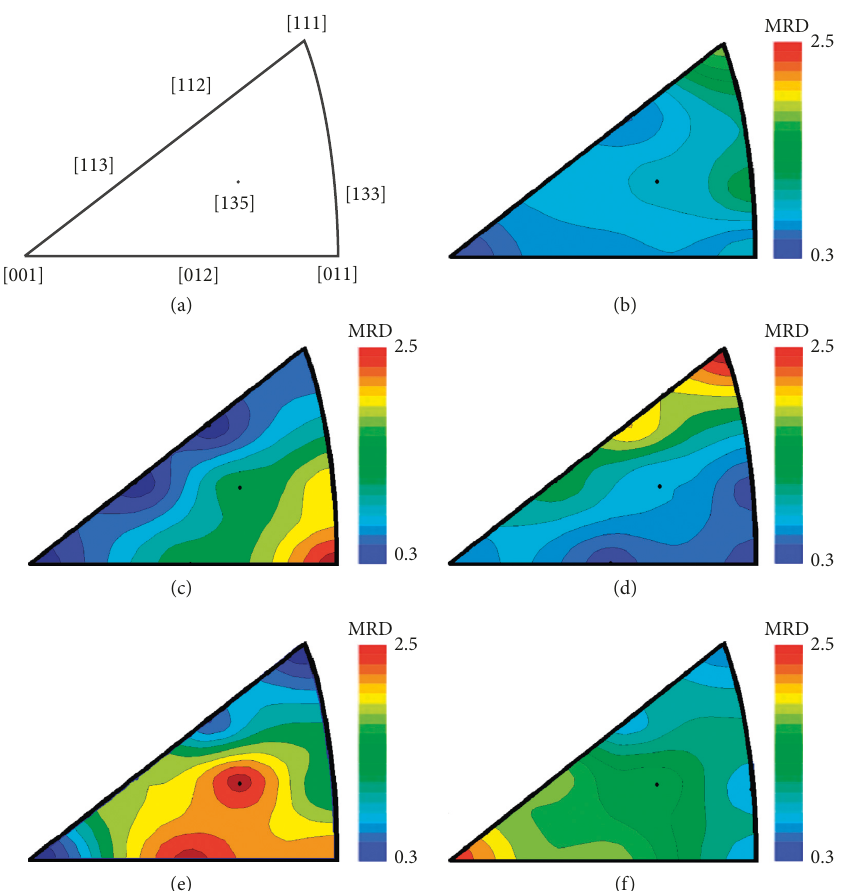
Figure 4: Simulated IPFs (inverse pole figures) expected for FCC (face-centered-cubic) bronze: (a) key to the fiber directions; (b) cast, thin FCC metal; (c) after compression or striking (brass or Goss texture); (d) with a c fiber texture often found in extruded metal; (e) after rolling; and (f) after annealing (simple cube or β fiber texture). Repeated bending introduces a texture similar to rolling. Contours are in units of multiples of a random